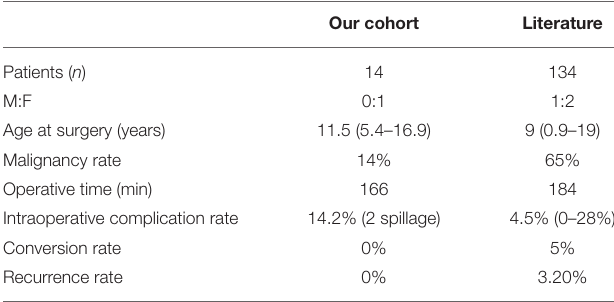
TABLE 3 | Comparison between our experience and literature. Our cohort